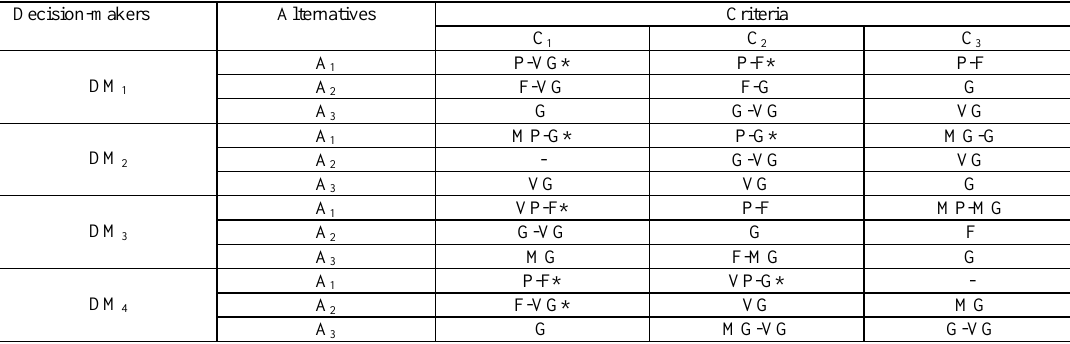
Table 2. Decision-makers’ evaluations of the three robots under subjective criteria with minor changes. The entries with * represent changes in Table